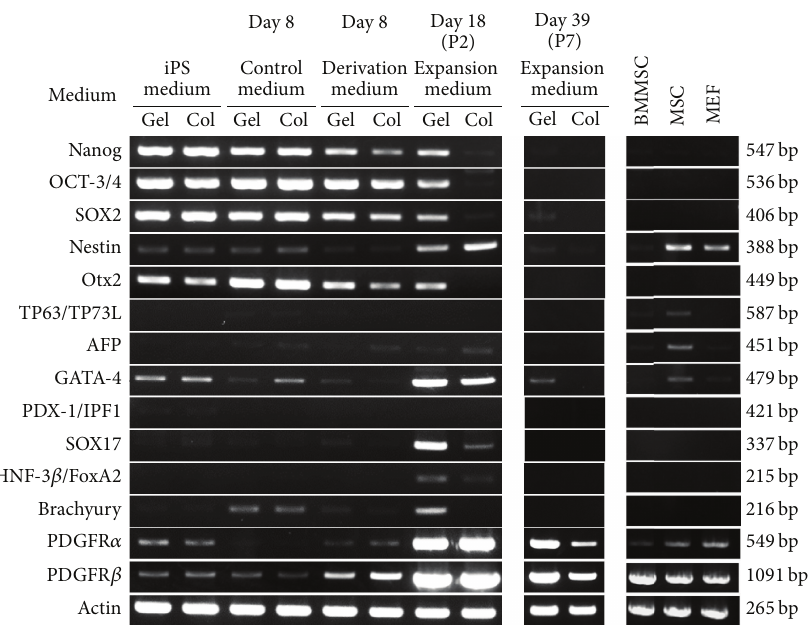
Figure 2: Effects of gelatin or collagen on germ-layer associated genes expression in iMSCs. Time-course (day 8 to day 39) genes expression in each cell with semiquantitative reverse transcription polymerase chain reaction. iPS medium; iPSCs on gelatin (Gel) or collagen (Col), control medium; iPSCs in 8 day-derivation without dexamethasone and ascorbic acid, derivation medium; iPSCs in 8 day-derivation, expansion medium; iMSCs at passages 2 (P2) and P7 in expansion medium, BMMSCs; bone marrow MSC at P5, MSC; MSCs from Invitrogen, and mouse embryonic fibroblast